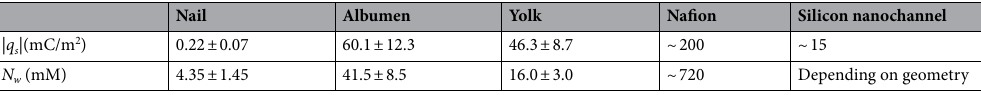
Table 1. Comparisons of surface charge density and Donnan concentration of nail plate, albumen and yolk with other